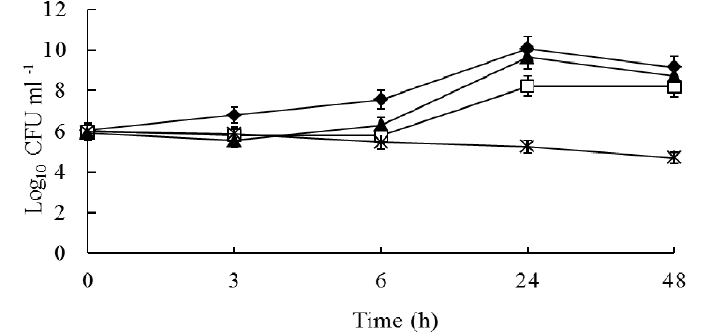
Figure 2. Time-kill curves of BCA and CPFX alone and in combination against clinical Methicillin -resistant S. aureus isolate 1662. The strain at starting inocula of 10 6 CFU/mL were exposed to in vivo -achievable concentrations of 32 µg/mL BCA alone and in combination with 64 µg/mL CPFX. At 0, 3, 6, 24, and 48 h, aliquots were removed from each test tube to examine the cell metabolism ability.